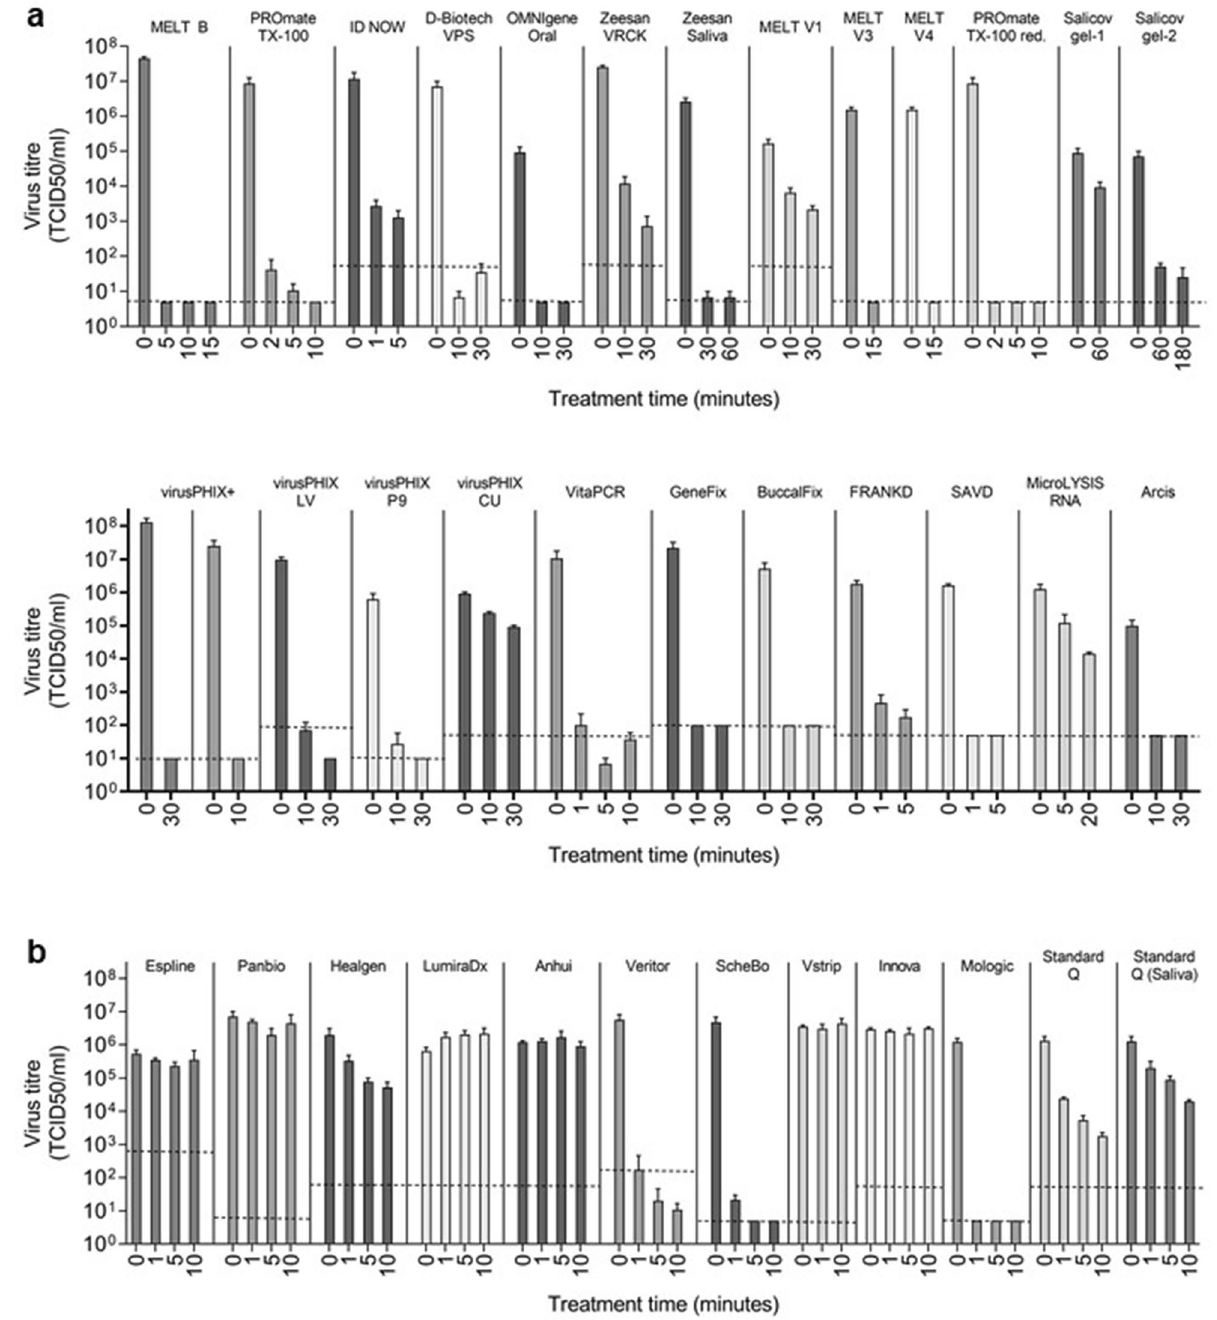
Figure 2. SARS-CoV-2 titre reductions following treatment with guanidine-free molecular extraction reagents and LFIA buffers. SARS-CoV-2 suspension was treated with guanidine-free molecular extraction reagents ( a ) or LFIA buffers ( b ), using the contact times and concentrations stated in Tables 1 and 2, respectively. SARS-CoV-2 was mock-treated with an equivalent volume of PBS in parallel. Samples were purified by methods indicated in Tables 1 and 2 to remove product-associated cytotoxicity, then titrated by TCID 50 on Vero E6 cells to determine virus titre. All treatments and mock-treatments were performed in triplicate; bars show the mean of triplicate inactivation tests and error bars the standard deviation. The limit of detection for each test was determined using the cytotoxicity control for each test, and is indicated on the graph for each test by a dashed line. Where cytotoxicity of sample replicates and/or treatment times for a product differed, the highest LOD for the entire test is displayed. Variation in virus titres for PBS-treated samples between product tests was due to differences in the titre of virus stock used, the ratio of sample to product or PBS used for treatment, and differing virus recovery following sample filtration with different methods 6 . VRCK: Virus RNA Collection Kit; VPS: Virus Preservation System; Triton X-100 red.: Triton X-100 reduced. Graphs created in GraphPad Prism version 9 https:// graph pad.